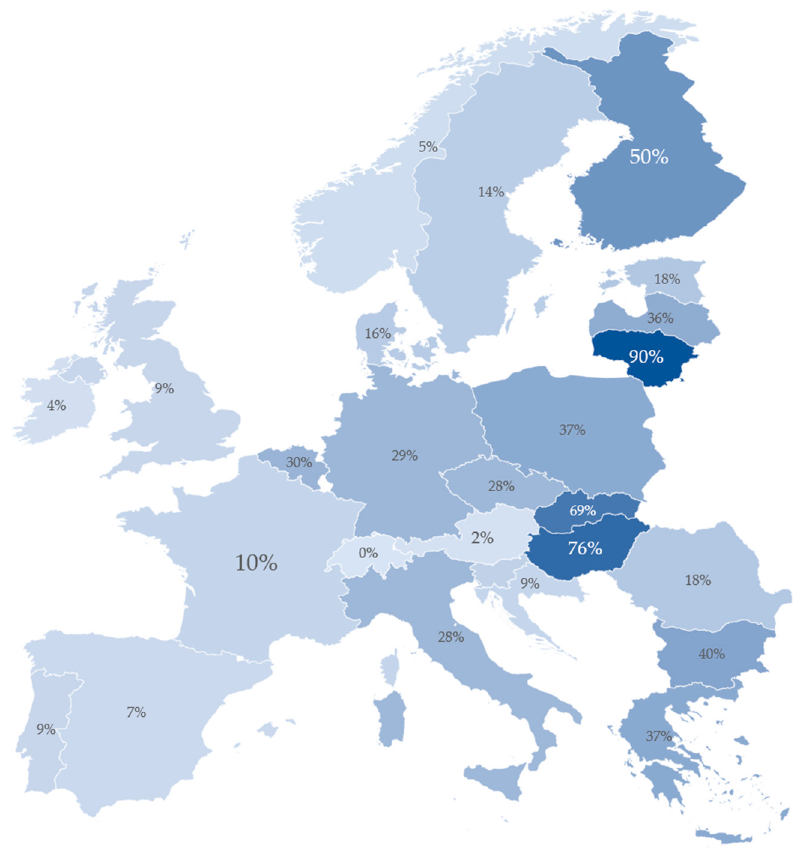
Figure 2. Share of Russian fossil fuel imports in total domestic consumption in 2019. Source: Euro- stat.